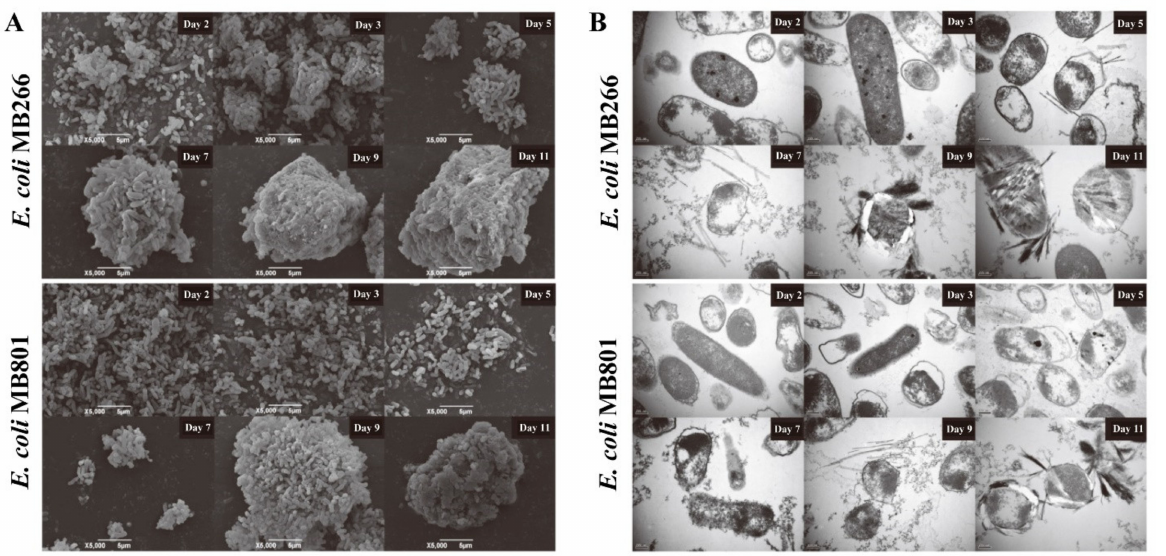
Figure 5. SEM ( A ) and TEM ( B ) micrographs of Mn oxide aggregate formation during the culture time course. The cells were cultured in LB broth containing 5 mmol/L MnCl 2 at the final concentration for 11 days. In ( A ), the samples were statically suspended for 30 min at room temperature, the precipitates were collected by pipetting out the supernatants, and 2.5% glutaraldehyde was added then placed at 4 ◦ C for 12 h, followed by sample drying with ethanol dehydration and freeze-drying processing for SEM observation. In ( B ), the samples were vigorously stirred and 2.5% glutaraldehyde was added and placed at 4 ◦ C for 12